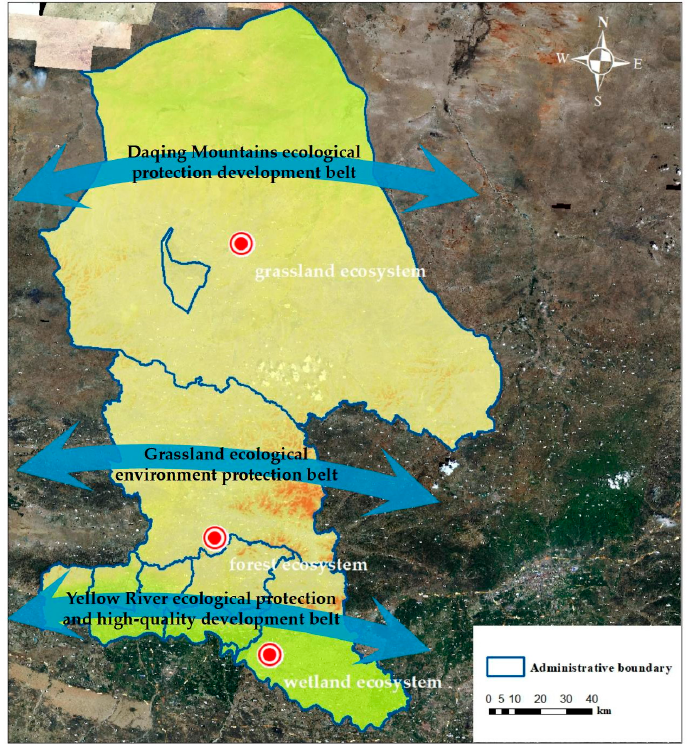
Figure 10. Ecological environmental protection and development in Baotou city .